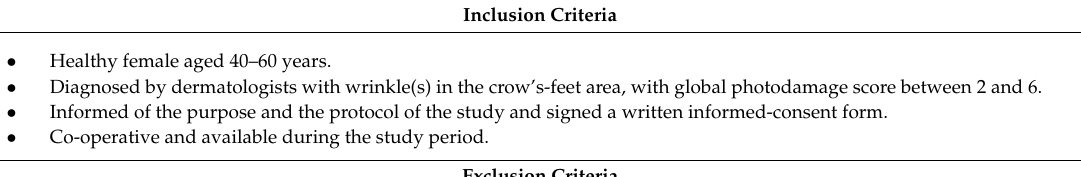
Table 2. Inclusion and exclusion criteria for recruitment of